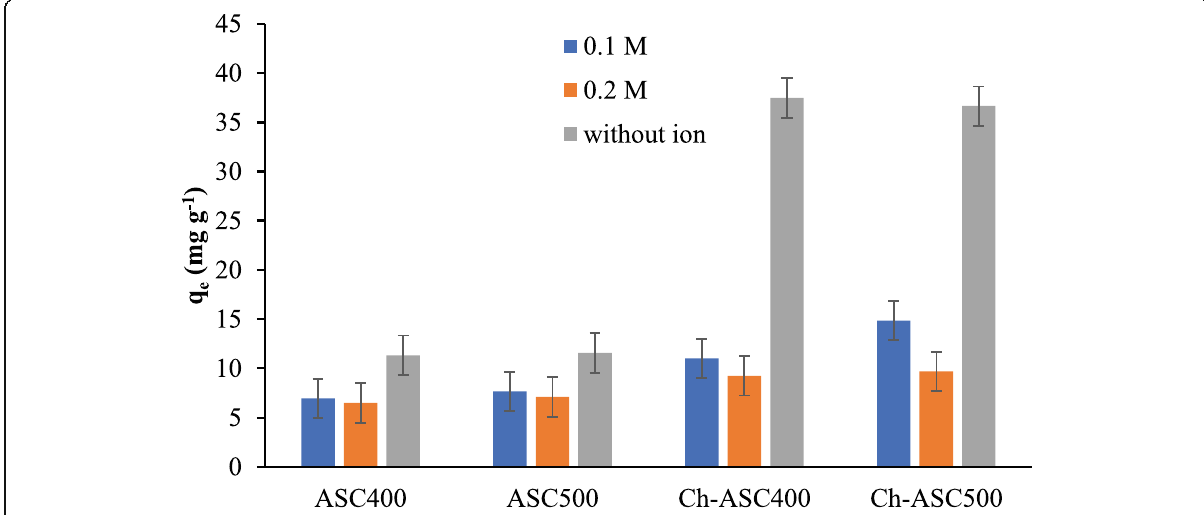
Fig. 10 Effect of presence of Cl − (adsorption conditions: initial Cr(VI) concentration: 55 mg L − 1 ; contact time: 120 min; pH: 1.5; temperature: 25